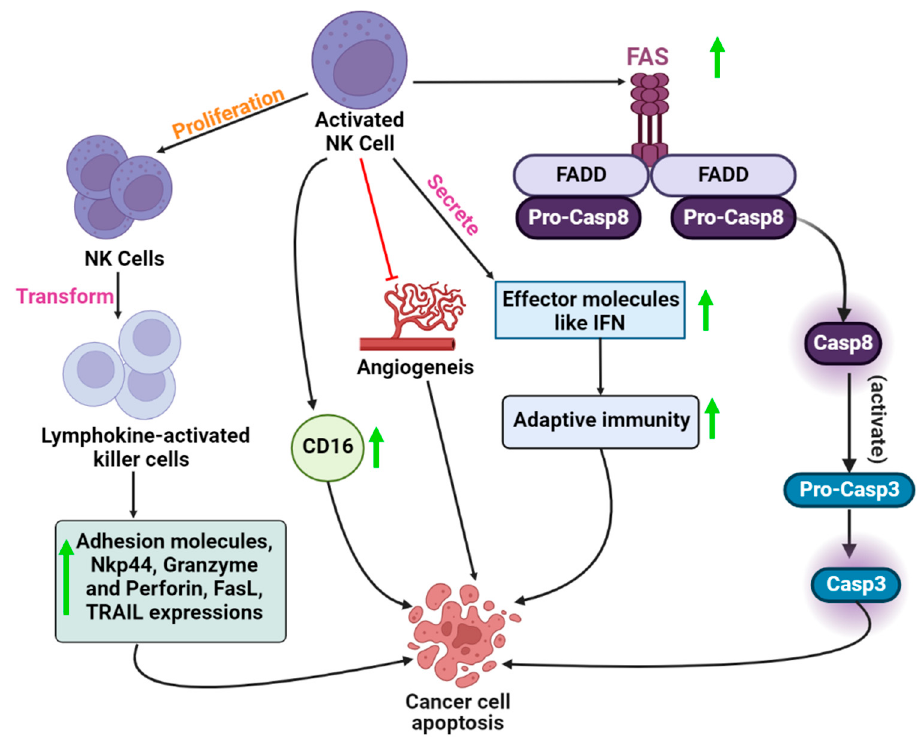
Figure 2. The mechanistic role of activated NK cells in cancer cell apoptosisincludes the activation of the Fas-mediated signaling pathway, inhibition of angiogenesis, high expression of CD16 cytokines, and transformation of NK cells to lymphokine-activated cells.